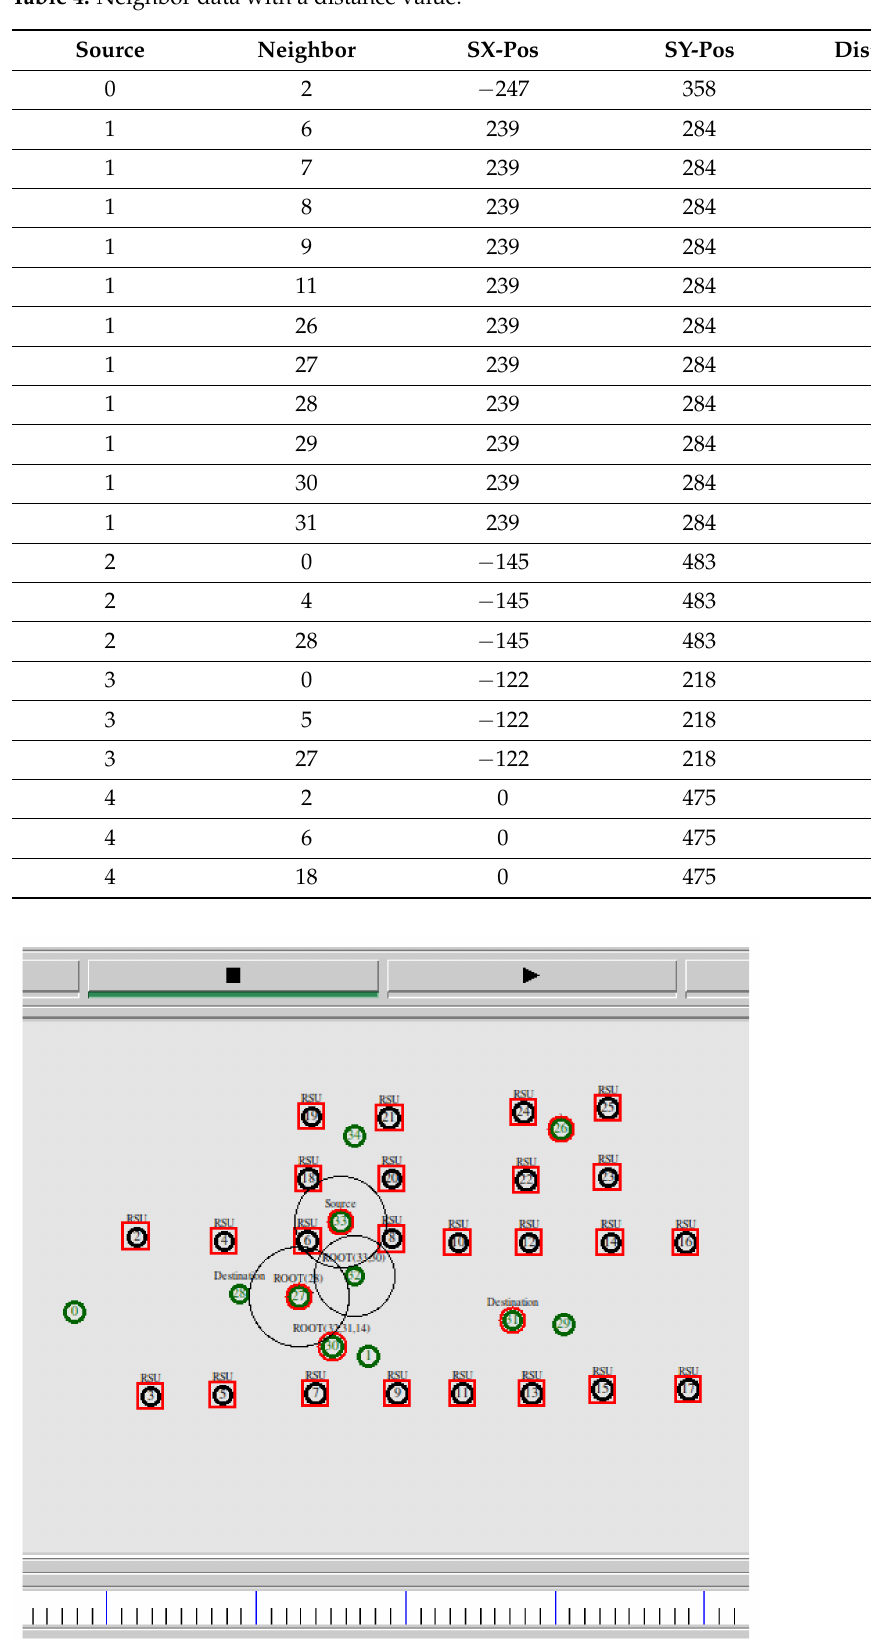
Table 4. Neighbor data with a distance value.